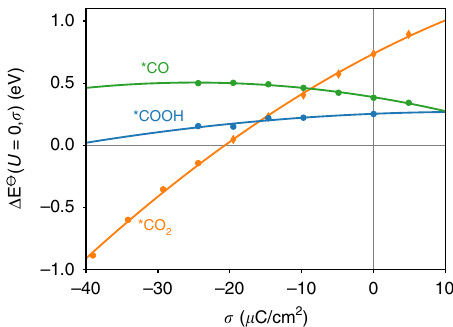
Fig. 4 Surface-charge-dependent formation energies. The formation energies Δ E (cid:3)(cid:4)(cid:3) are given for the key reaction intermediates *CO 2 , *COOH, and *CO. Energies are referenced to CO and H O in the gas phase, without 2 2 corrections for the zero-point energy or fi nite temperature. The dependence on surface-charge density σ at the (211) facet of Gold is shown without regard of the CHE – Frumkin potential-dependent term in Eq. (5). In the case of *CO 2 , the formation energy for surface-charge densities > − 20 µ C/cm 2 was obtained from fi xed geometry, single-point calculations using a constrained *CO 2